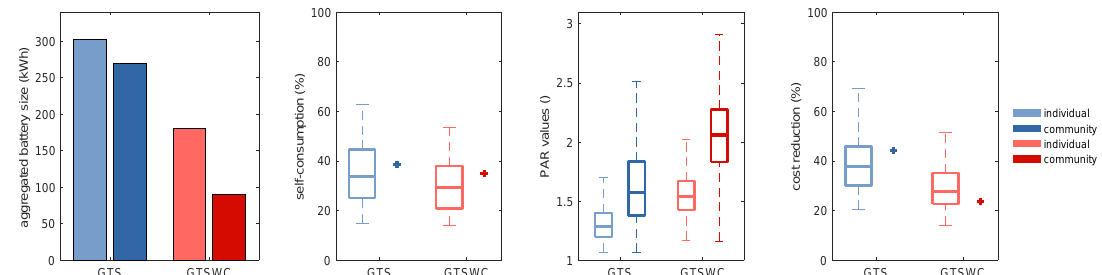
Figure 6. Comparison between the centralised and decentralised approaches. The aggregated optimal battery sizes for the GTS and GTSWC approach in the cases of a single centralised battery and individually-owned decentralised batteries are shown. Furthermore, the three metrics: self-consumption, PAR of the aggregated load and cost reduction are investigated for simulations based on these optimally sized storage installations. All simulations are performed over the period of an entire year, i.e., winter 2010 to autumn